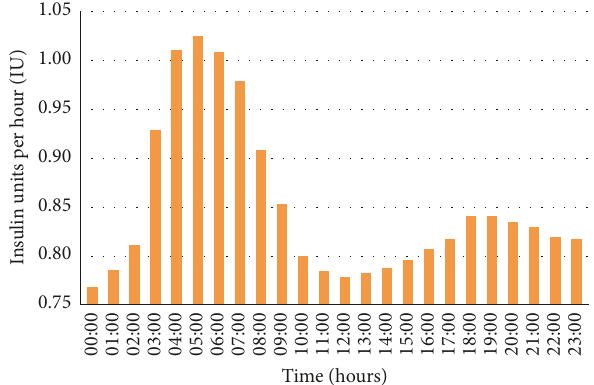
Figure 1: Circadian distribution of basal insulin in the whole study group. Table 2: Results of the univariate and multivariate linear regression analysis with HbA1c as the dependent variable. Variable